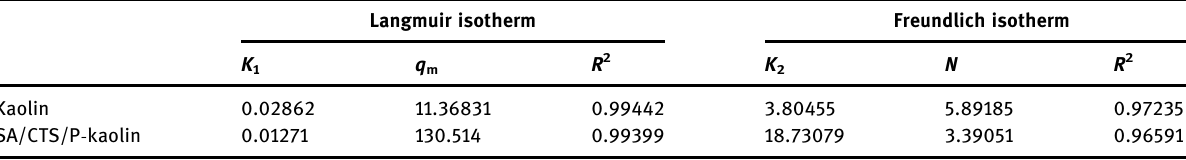
Table 3: Langmuir and Freundlich isotherm parameters for Cu 2 + removal by